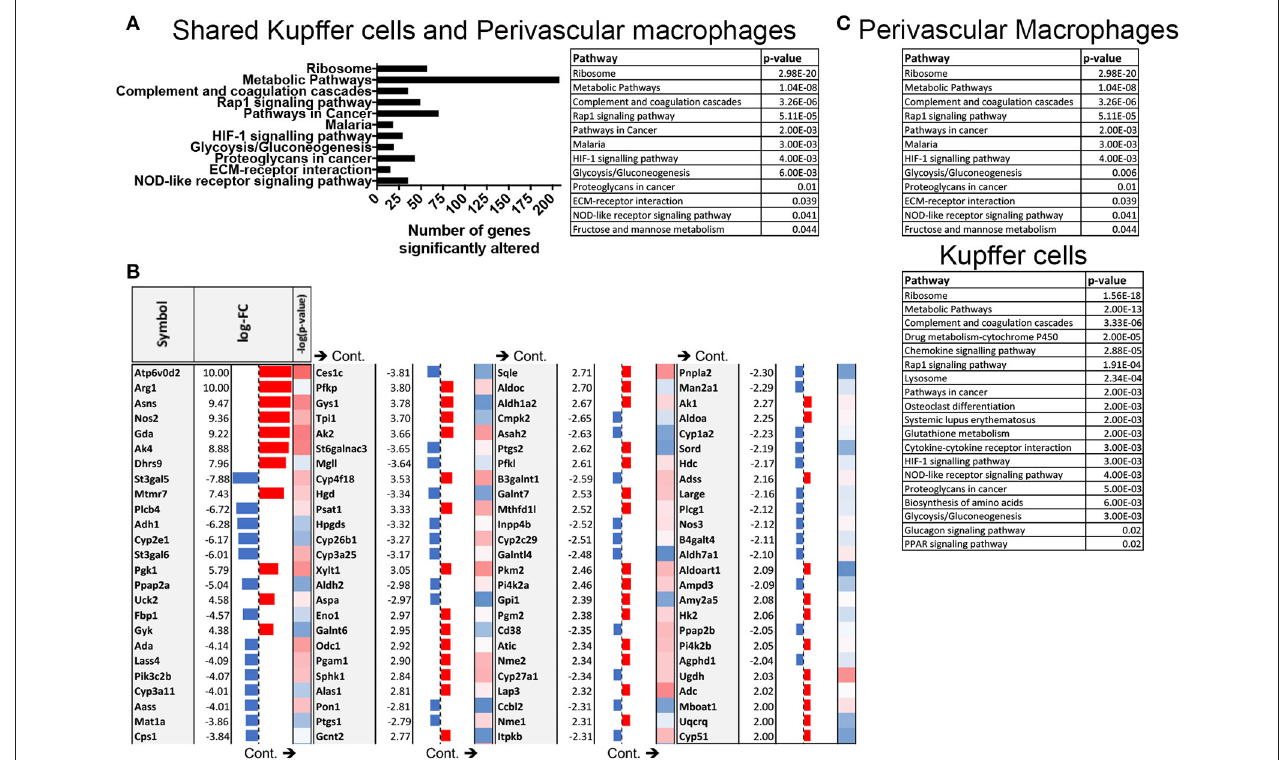
FIGURE 3 | S. mansoni infection induces profound alterations to metabolic pathways in hepatic macrophages. Expression data from microarrays were log transformed and p -values were calculated in R. Corrected P -values and fold changes were used for pathway analysis. (A) Pathways that are significantly altered in both perivascular macrophages and Kupffer cells at 10-weeks post S. mansoni infection as calculated using Advaita Corporation iPathwayGuide table depicts pathway name and p -values are Bonferroni corrected (B) The table shows top absolute values of the log-fold changes in both perivascular macrophages and Kupffer cells at 10 weeks post S. mansoni infection (all log-FC ≥ 2) of genes identified in the KEGG metabolic pathway using Advaita Corporation iPathwayGuide. The –log 10 of the p -values range from 1.3 (blue) to 3.5 (red). (C) Tables listing pathway name and Bonferroni corrected p -value of the significantly altered pathways in Perivascular macrophages and kupffer cells as calculated using Advaita Corporation